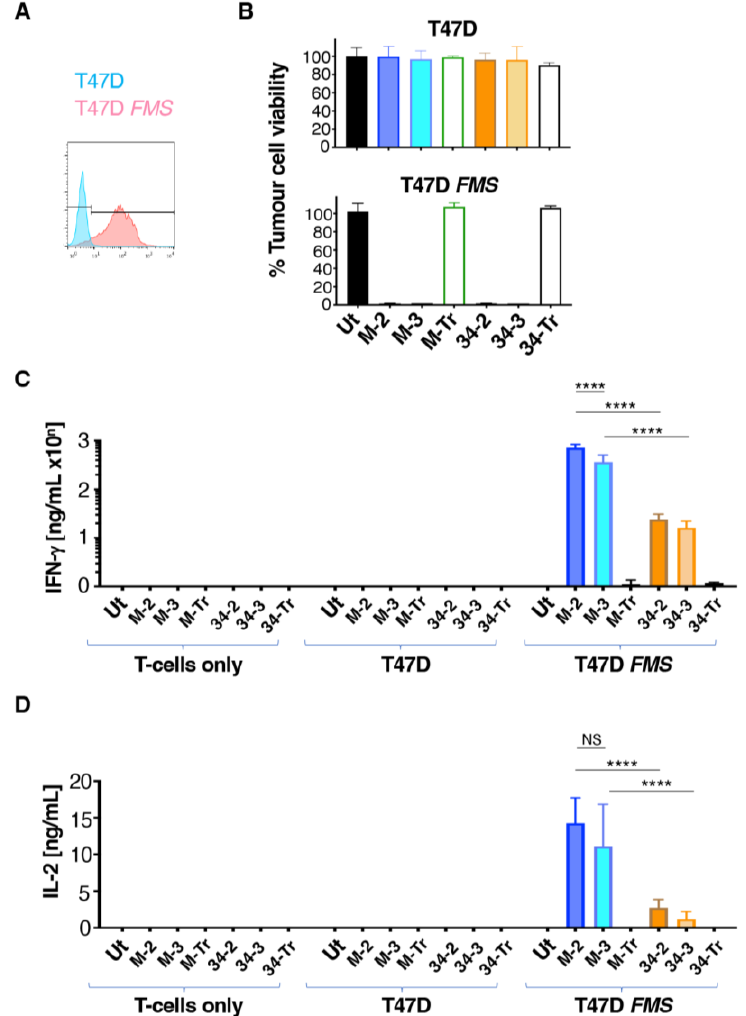
Figure 3. Co-cultivation of CAR T-cells with T47D tumour cells discordant for M-CSFR expression. ( A ) Flow cytometric analysis of cell surface M-CSFR expression in T47D and T47D FMS cells. ( B ) Engineered human T-cells were co-cultivated overnight at a 1:1 effector:target ratio with T47D (lacks M-CSFR) or T47D FMS (expresses M-CSFR) target cells. Tumour cell viability was evaluated using an MTT assay (mean ± SD, n = 3 technical replicates). Data are representative of 7 independent replicates, in which similar results were obtained. Supernatant collected at termination of these cultures was analysed for IFN- γ ( C ) and IL-2 ( D ) concentrations (mean ± SD, n = 3 biological replicates). Statistical analysis was undertaken using two-way ANOVA and selected differences are shown. **** p < 0.0001; NS – not significant .